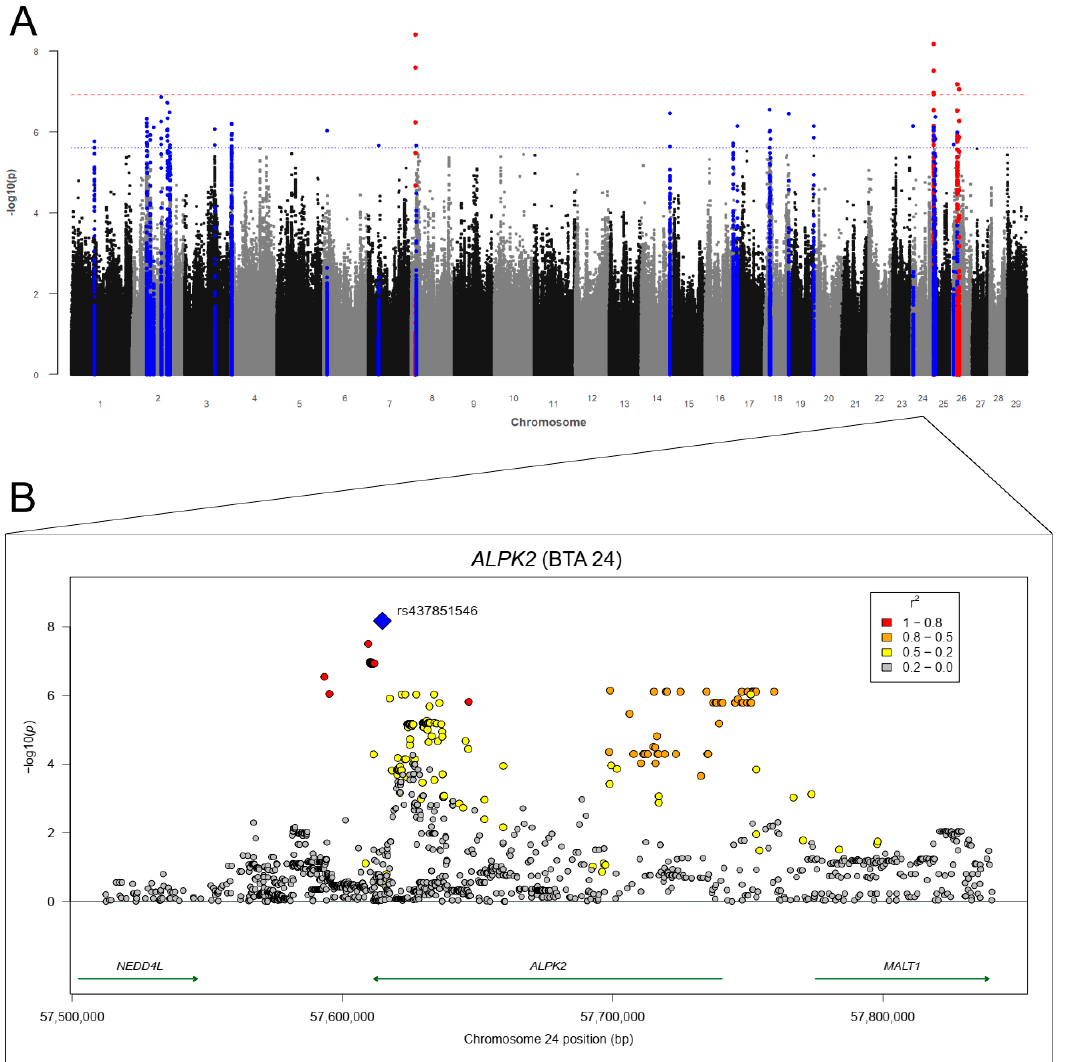
Figure 3. ( A ) Manhattan plot for − log10 p -values of marker effects for residuals of fecal egg counts of gastrointestinal nematodes (RES-GIN). Markers above the genome-wide significance threshold p Bonf (red dashed line) are highlighted in red and markers above the suggestive significance threshold p Sug (blue dashed line) are highlighted in blue. Markers within a distance of 125 kb up- and downstream of the significantly or suggestively associated SVs are highlighted in red or blue, respectively. ( B ) Regional association plot for the α kinase 2 ( ALPK2 ) gene on BTA 24 with corresponding flanking regions (+/ − 100,000 bp). The SNP rs437851546 (blue square) was the highest associated SNP ( p = 6.63 × 10 − 9 ) for RES-GIN on BTA 24. Circles show GWAS p -values, with different colors indicating linkage disequilibrium (LD): red: LD 0.8 to 1.0, orange: LD 0.5 to 0.8. yellow: LD 0.2 to 0.5, gray: LD 0.0 to 0.2. Genes with a green arrow pointing to the right are located on the forward strand, genes with an arrow pointing to the left are located on the reverse strand.